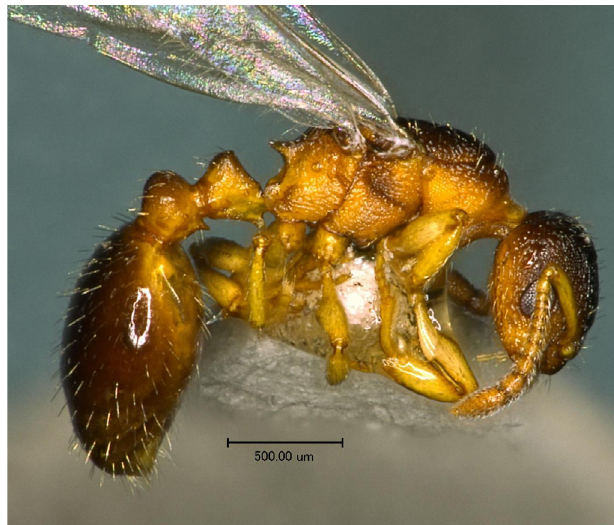
Fig 3 . Female sexual of the inquiline ant Leptothorax kutteri from Arıkmusa Village,